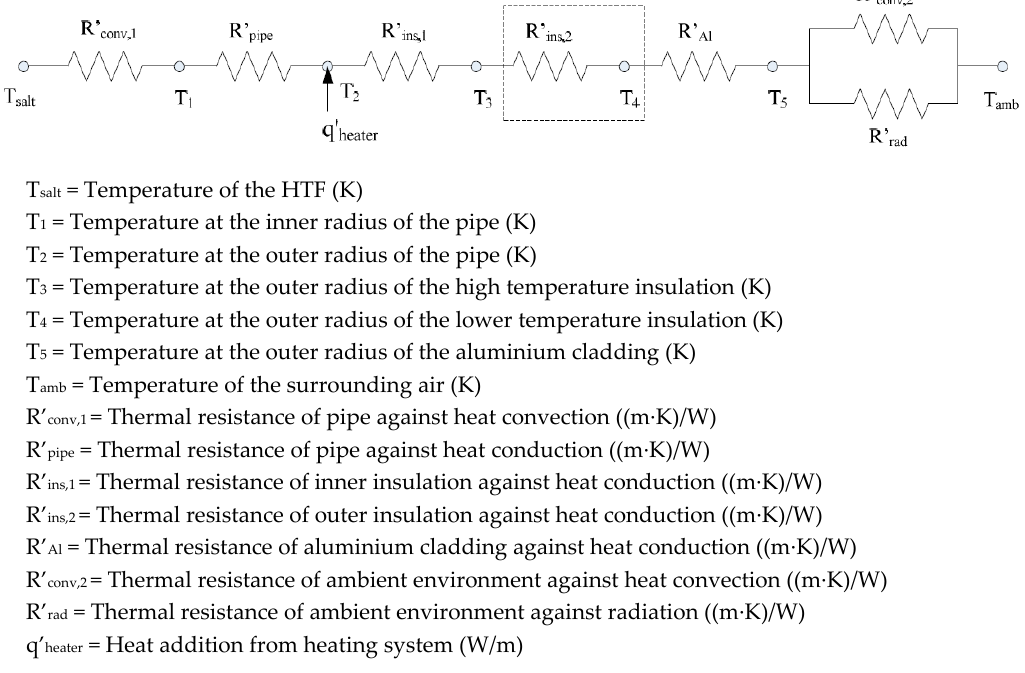
Figure 4. Circuit schematic of pipe heat transfer.